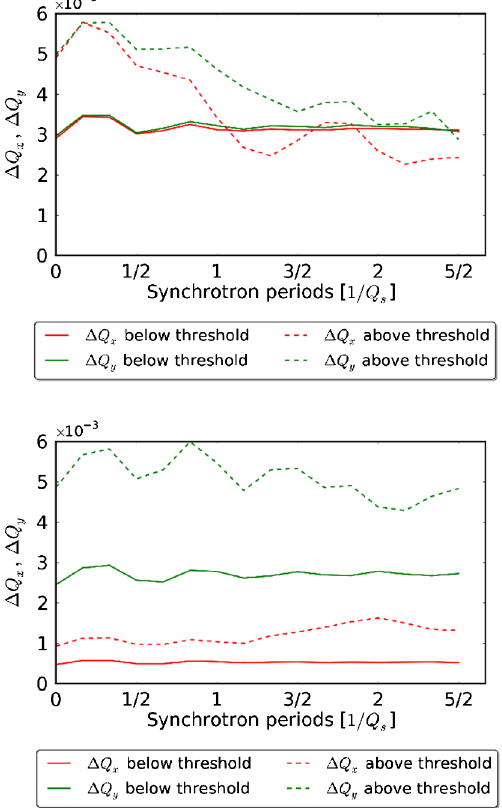
FIG. 22. Incoherent tune spread evolution at 450 GeV and a transverse normalized emittance of 2 : 5 (cid:3) m in straight